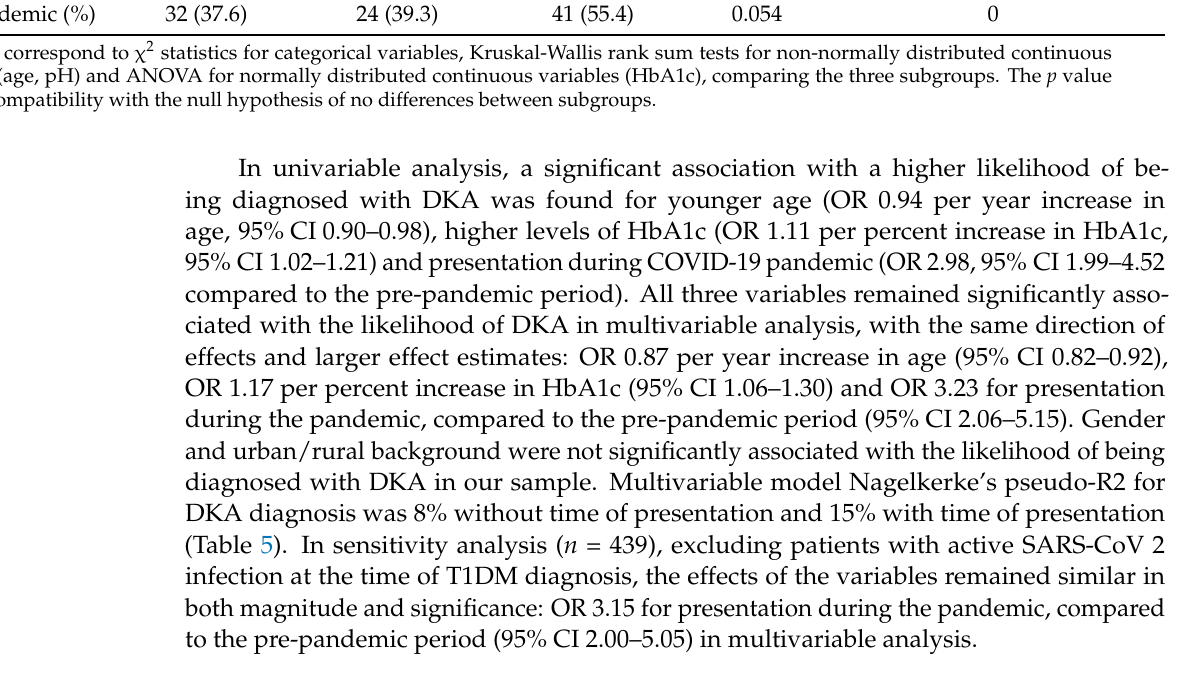
Table 5. Logistic regression of variables associated with DKA